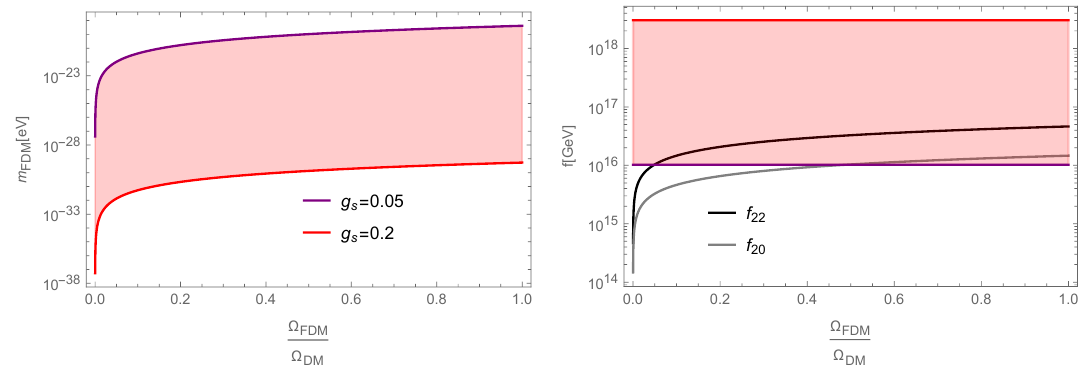
Figure 8 . Predictions for the thraxion mass and decay constant as functions of the FDM abun- dance. All plots are drawn fixing M = 10 : increasing M makes the thraxions lighter. We